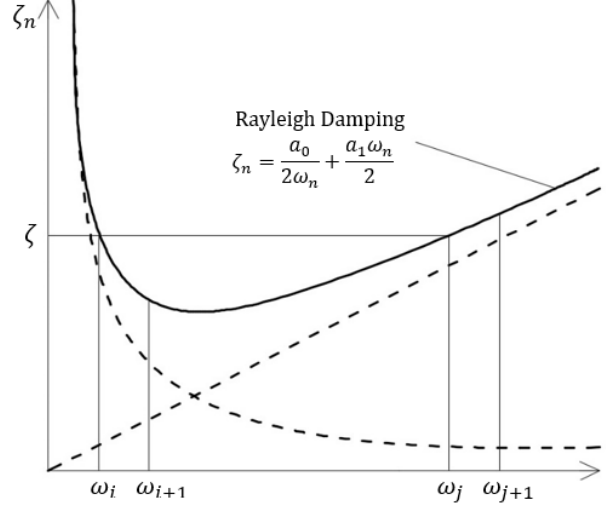
Figure 5. Variation of damping with the modal frequency in Rayleigh Damping Model.